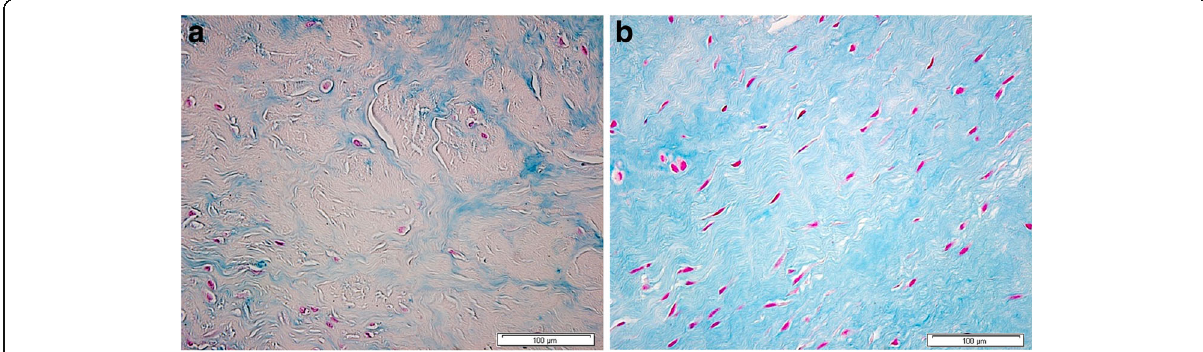
Fig. 4 Rabbit meniscus stained with Alcian blue. The extracellular matrix proteoglycans are decreased in ( a ) the OA meniscus, compared with ( b ) the healthy meniscus. Magnification: ×